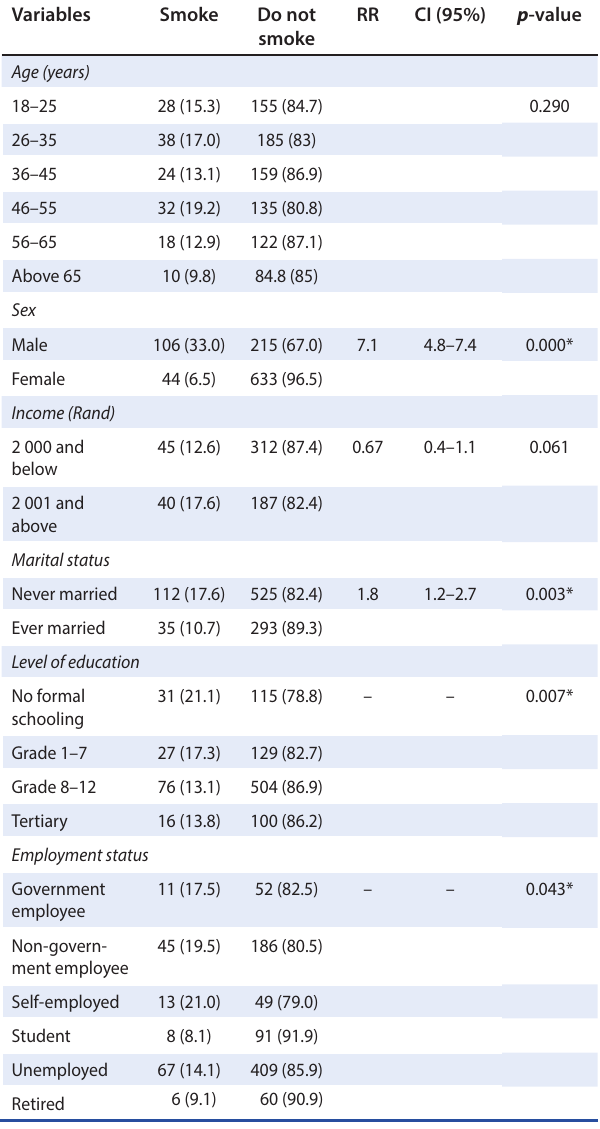
*Statistically significant at p ≤